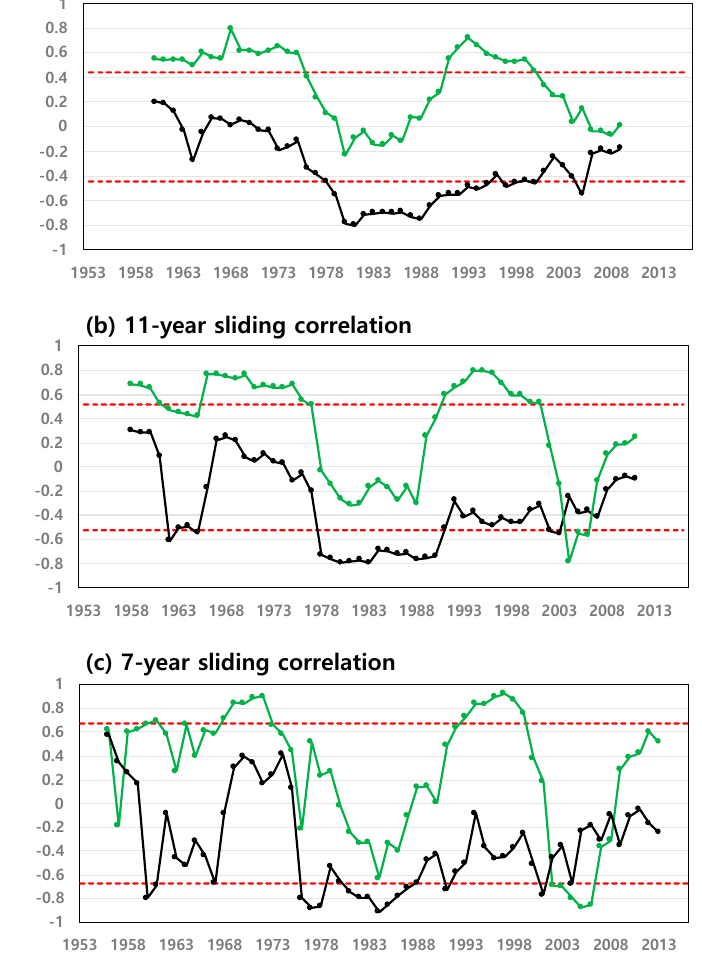
Figure 2. Sliding correlations with ( a ) 15-year (from year − 7 to year +7 period), ( b ) 11-year (from year − 5 to year +5 period) and ( c ) 7-year (from year − 3 to year +3 period) sliding windows between EASMI and indices of the tropical IO SSTA (Black line: NIOI, Green line: IODI line). The dashed red lines represent the significance at the 90% confidence level with the Student’s t -test in each window length.